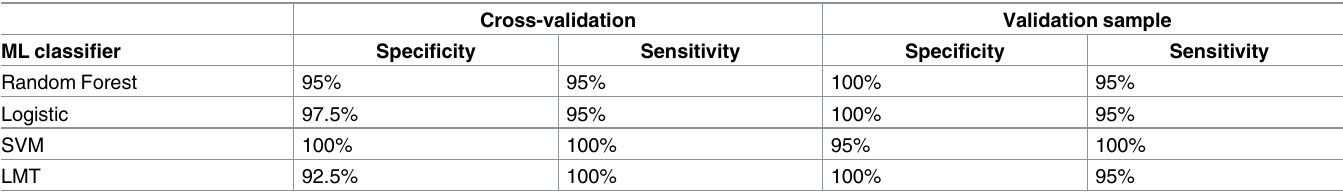
Table 5. Sensitivity and specificity of the classification models in the 10-fold cross-validation and in the validation